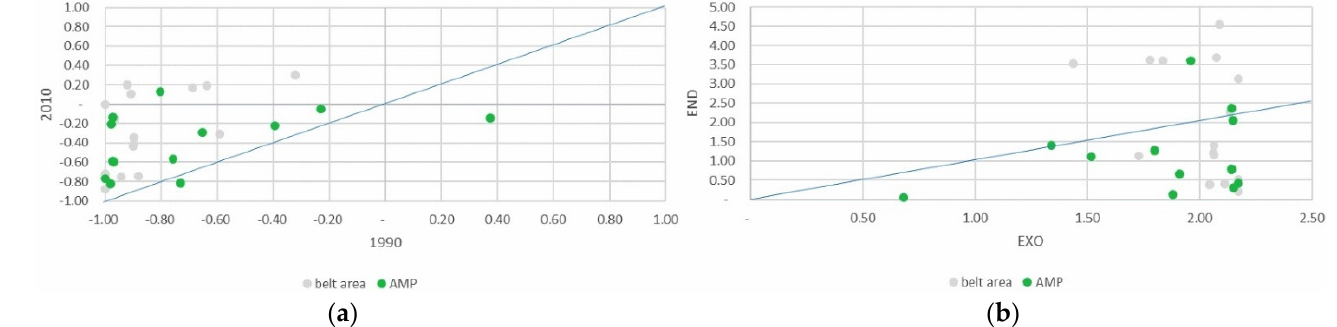
( b ) Figure 16. ( a , b ) PSI and DPSI for meadows and pastures. Source: Drawn up by the authors using data provided by the ISTAT. Trends in the Specialization in Vegetables (1990–2010) Even though the area devoted to vegetables increased by 23% over the study period, the specialization in this crop in the municipalities in the park did not vary significantly, as the PSI remained below 0. The weakness of the exogenous component of the DPSI in many of these municipalities indicates less significant variations than the regional average (Figure 17a,b). ( a ) ( b ) Figure 17. ( a , b ) PSI and DPSI for vegetables. Source: Drawn up by the authors using data provided by the ISTAT. Trends in the Specialization in Family Vegetable Gardens (1990–2010) Although there was huge growth in the area devoted to family vegetable gardens